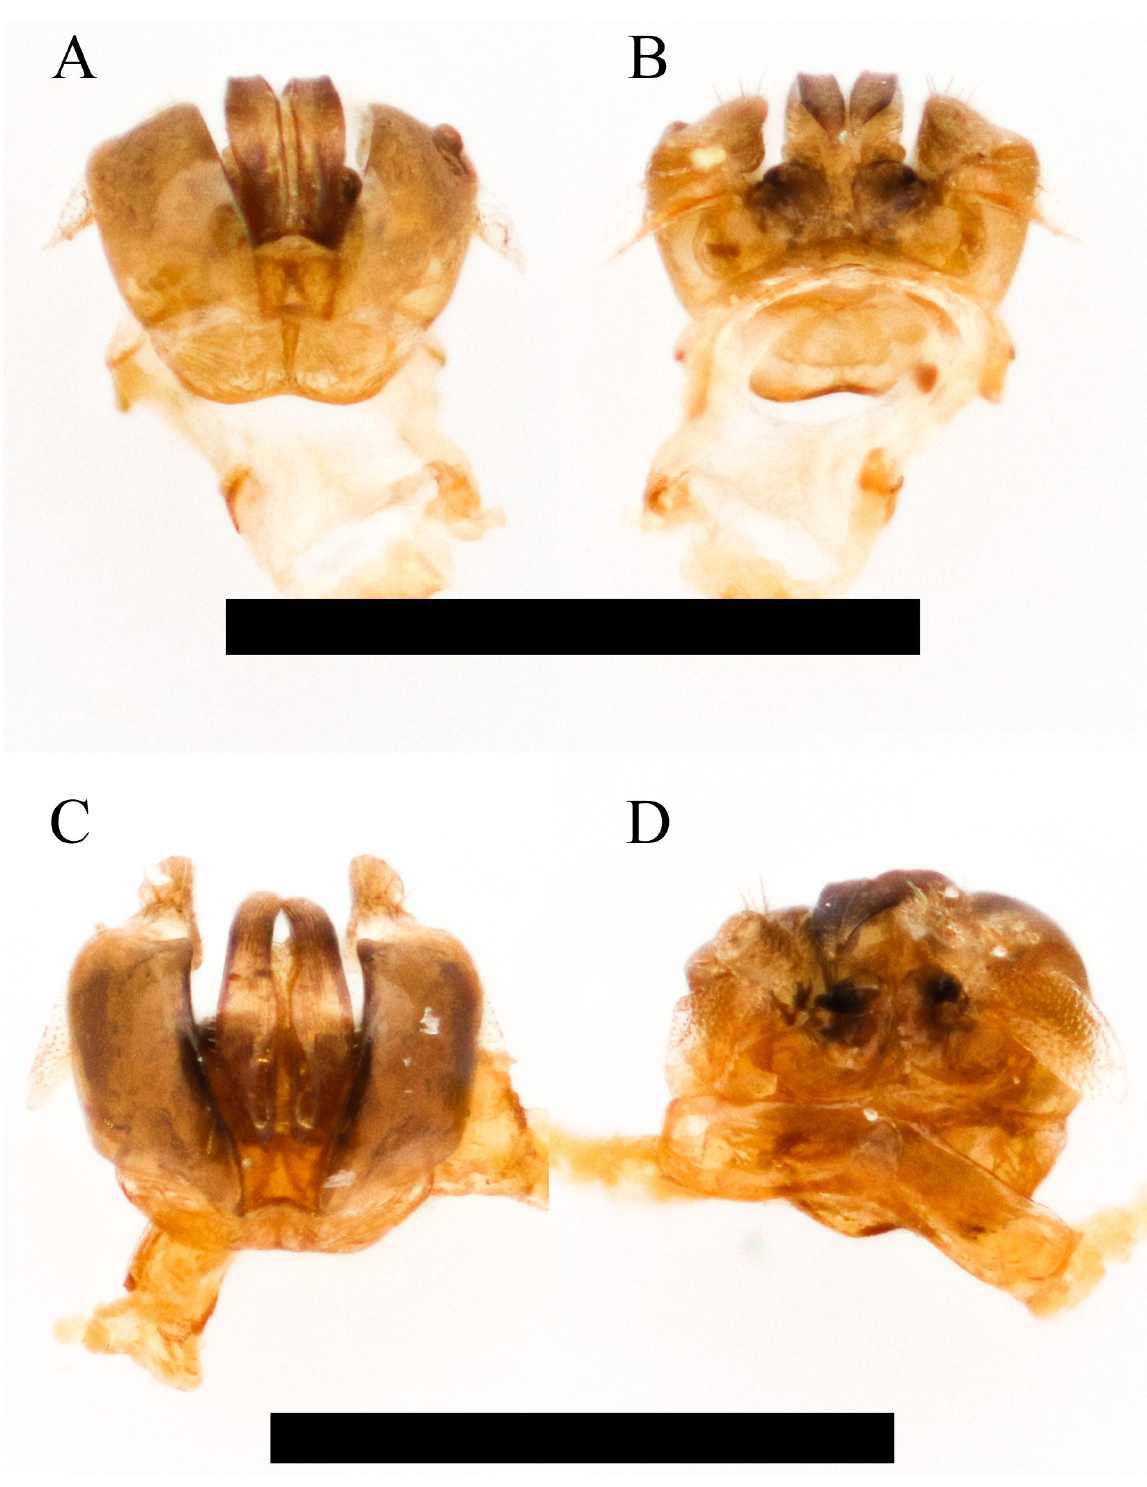
Fig. 4. — Genital capsule of Lasioglossum ( Dialictus ) dominicense sp. nov. Paratype, ♂. A . Dorsal view. B . Ventral view. — Genital capsule of Lasioglossum ( Dialictus ) kilpatrickae sp. nov. Paratype, ♂. C . Dorsal view. D . Ventral view. Scale bars = 1